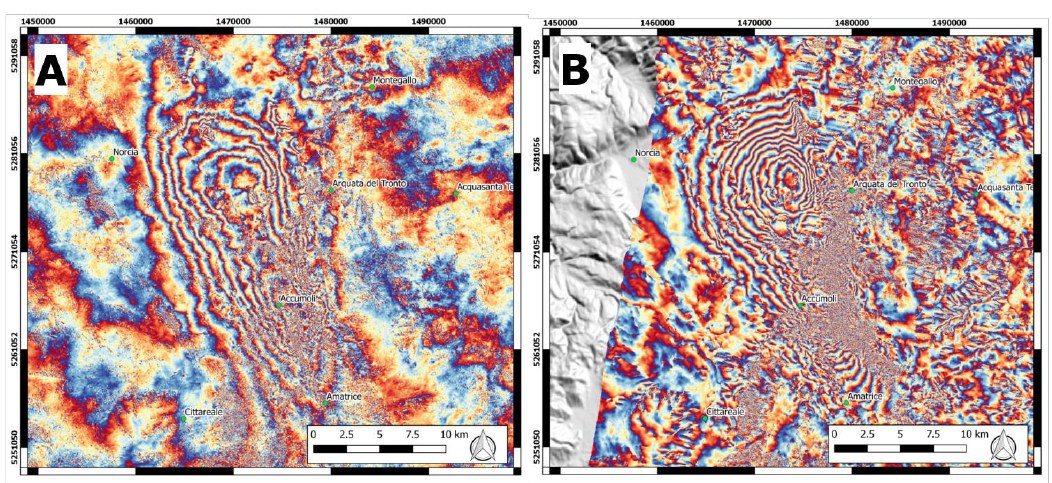
Figure 1 . Examples of InSAR wrapped maps from: A) S1 ascending pair (Id-4 in Table 1); B) CSK